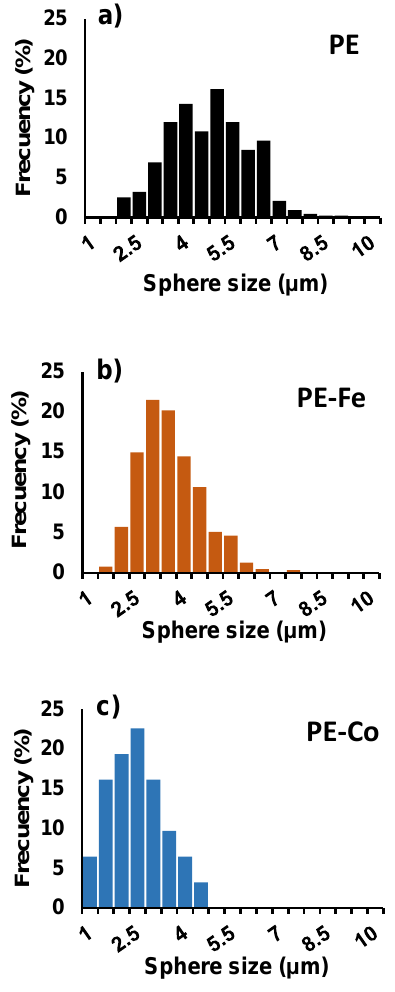
Figure 4. ( a – c ) Sphere size distribution.